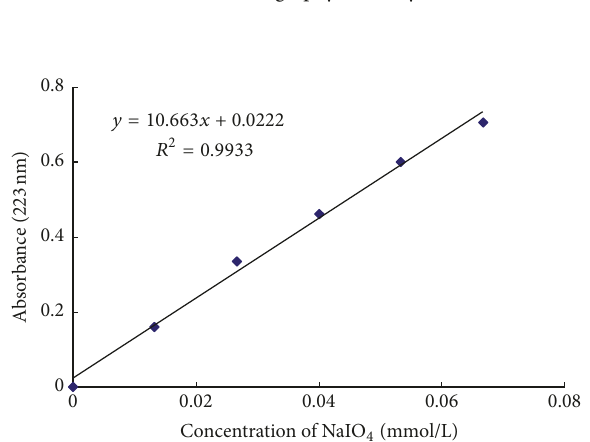
Figure 3: Standard curve of NaIO 4 concentration.